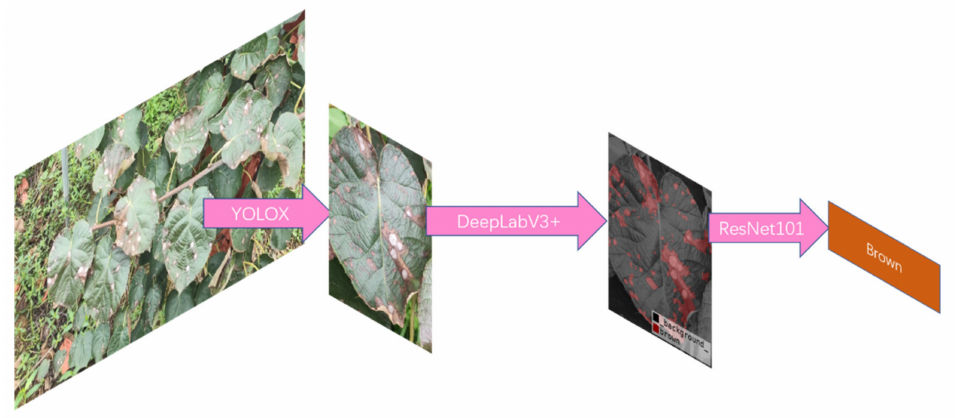
Figure 5. Overall processing flow of the